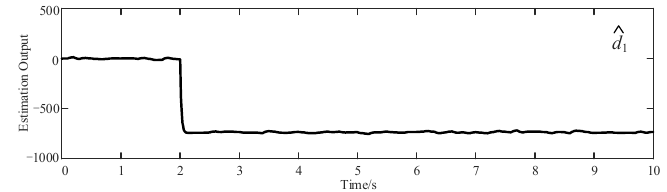
Figure 14. Estimation of external disturbance of EDE.